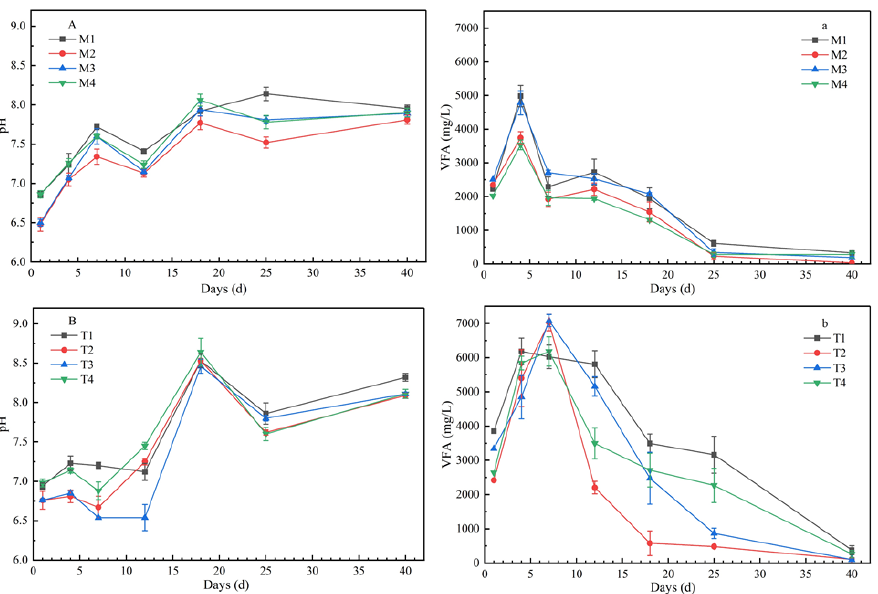
Figure 2. Profiles of volatile fatty acid (VFA) concentration and pH value variation of co-digestion under mesophilic conditions ( a , A ) and thermophilic conditions ( b , B ). (note: the data were the mean of three repetitions, and error bars indicate standard deviation. a and A represent VFA concentration and pH value at mesophilic conditions, b and B represent VFA concentration and pH value at thermophilic